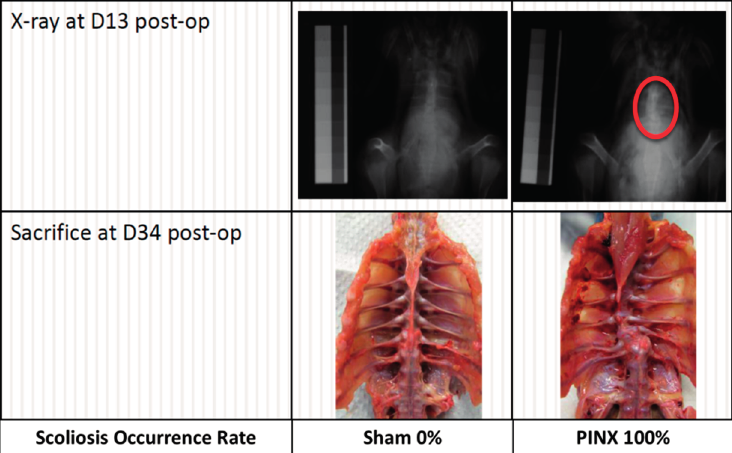
Figure 3. Occurrence of scoliosis in Kamei chickens. Unisex local bred Kamei chickens were pinealectomized (PINX) three days after hatching. X-ray taken thirteen days after the operation revealed a development of spinal curvature (encircled in red). At 34 days post-operatively, the chickens were sacrificed and autopsy was conducted to evaluate the incidence of scoliosis. All of the chickens in the PINX group demonstrated scoliosis ( n = 7), while no scoliosis was detected in the sham-operated control group ( n =